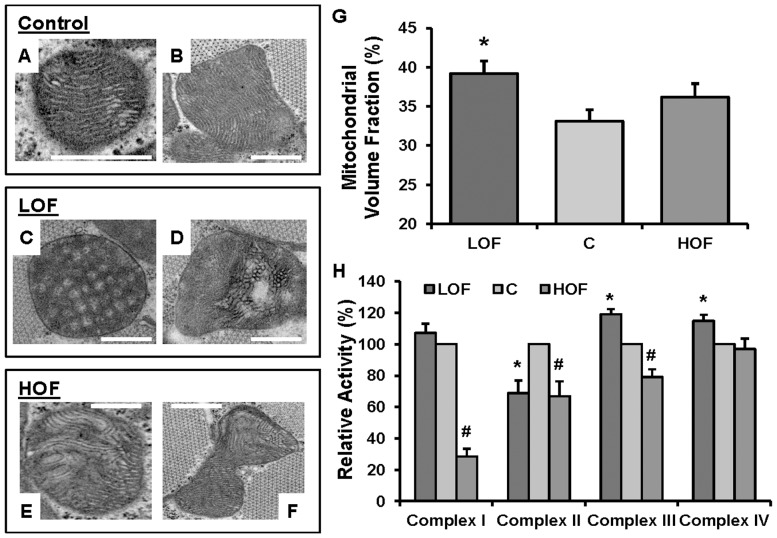
Morphological and functional characterization of control, LOF, and HOF thoracic muscle mitochondria.(A and B) Representative electron micrographs of thoracic muscle mitochondria from control flies. (scale = 500 nm) (C) Honeycomb-patterned mitochondria from LOF (volume fraction = 23.1±5.7%) (scale = 500 nm). (D) Mitochondria with large-amplitude swelling (the transparent “empty” spaces) from LOF (volume fraction 6.8±1.8%) (scale = 500 nm). (E and F) Mitochondria with microswelling inside the cristae and regional distortion; some of the distorted cristae were rounded (circular profile), from HOF flies (volume fraction 8.0±1.2%) (scale = 500 nm). (G) Mitochondrial volume fraction of control, LOF, and HOF. A significant increase in mitochondrial volume fraction was detected in the LOF samples (* p<0.01, n = 9). Each bar represents the mean ±SEM of 9 repeated measurements. (H) Activities of respiratory chain complexes in mitochondria isolated from control, LOF, and HOF thoracic muscle. Compared to the control, the activity of LOF respiratory chain complex II was reduced; however, the activities of complexes III and IV were increased (* p<0.05, n = 6). In HOF, the activities of complexes I, II and III were reduced, and the activities of complex IV was unchanged (# p<0.05, n = 6). All of the activities are presented as percentages of the control values (mean ±SEM).